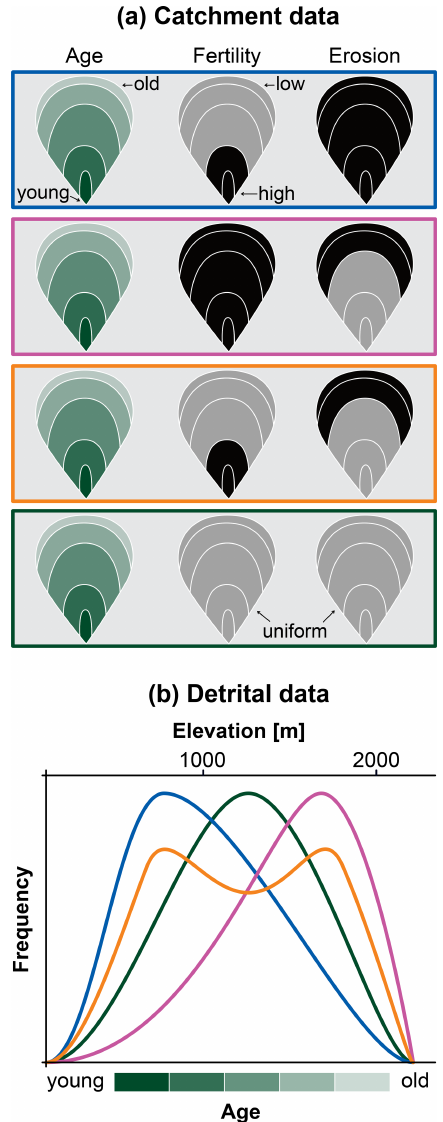
Figure 2. Qualitative sketch to illustrate the effect of mineral fer- tility and erosion on the detrital distribution. (a) The catchment of Fig. 1b with known bedrock age (shades of green) is subject to three scenarios of spatially varying fertility and erosion. The box outlines refer to the curves below. (b) Detrital distributions obtained from the different scenarios in (a) . The green curve refers to spatially uniform erosion and